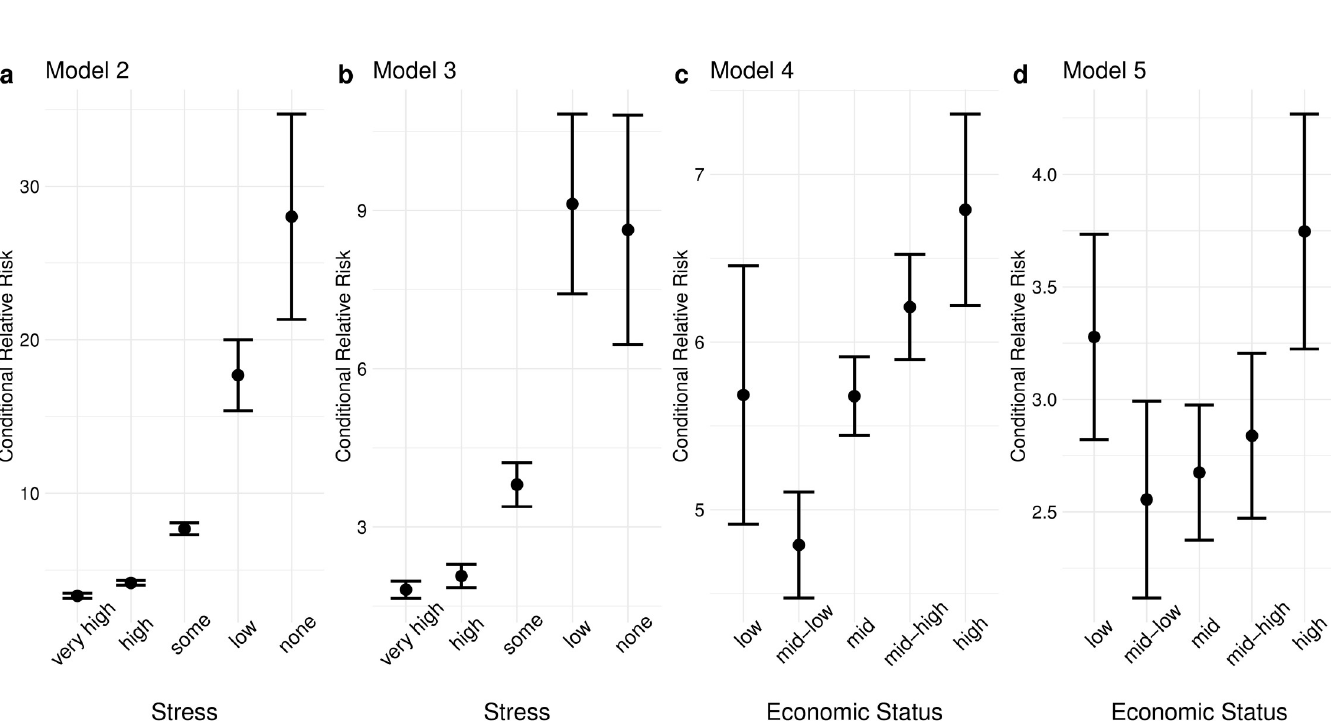
Fig 3. Relative risk for each category of stress and economic status. All covariates not involved in the interaction were set to zero or the reference category. Standard errors were estimated with the delta method. The error bars indicate 90% confidence intervals.